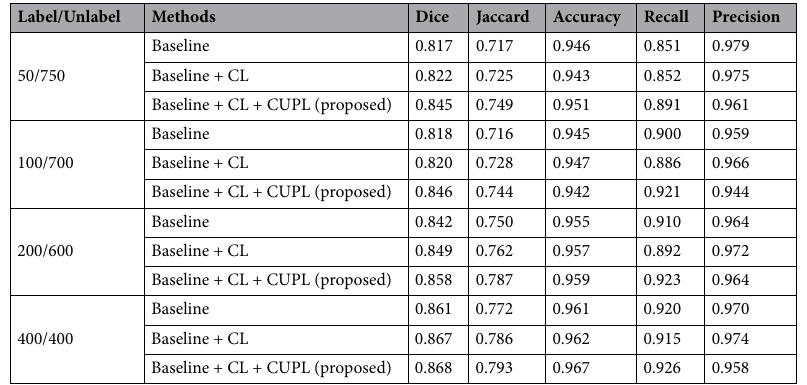
Table 1. Segmentation accuracy (Jaccard, Dice coefficient, Accuracy, Recall and Precision) comparison of CL and CUPL in our method on Kvasir-SEG dataset.